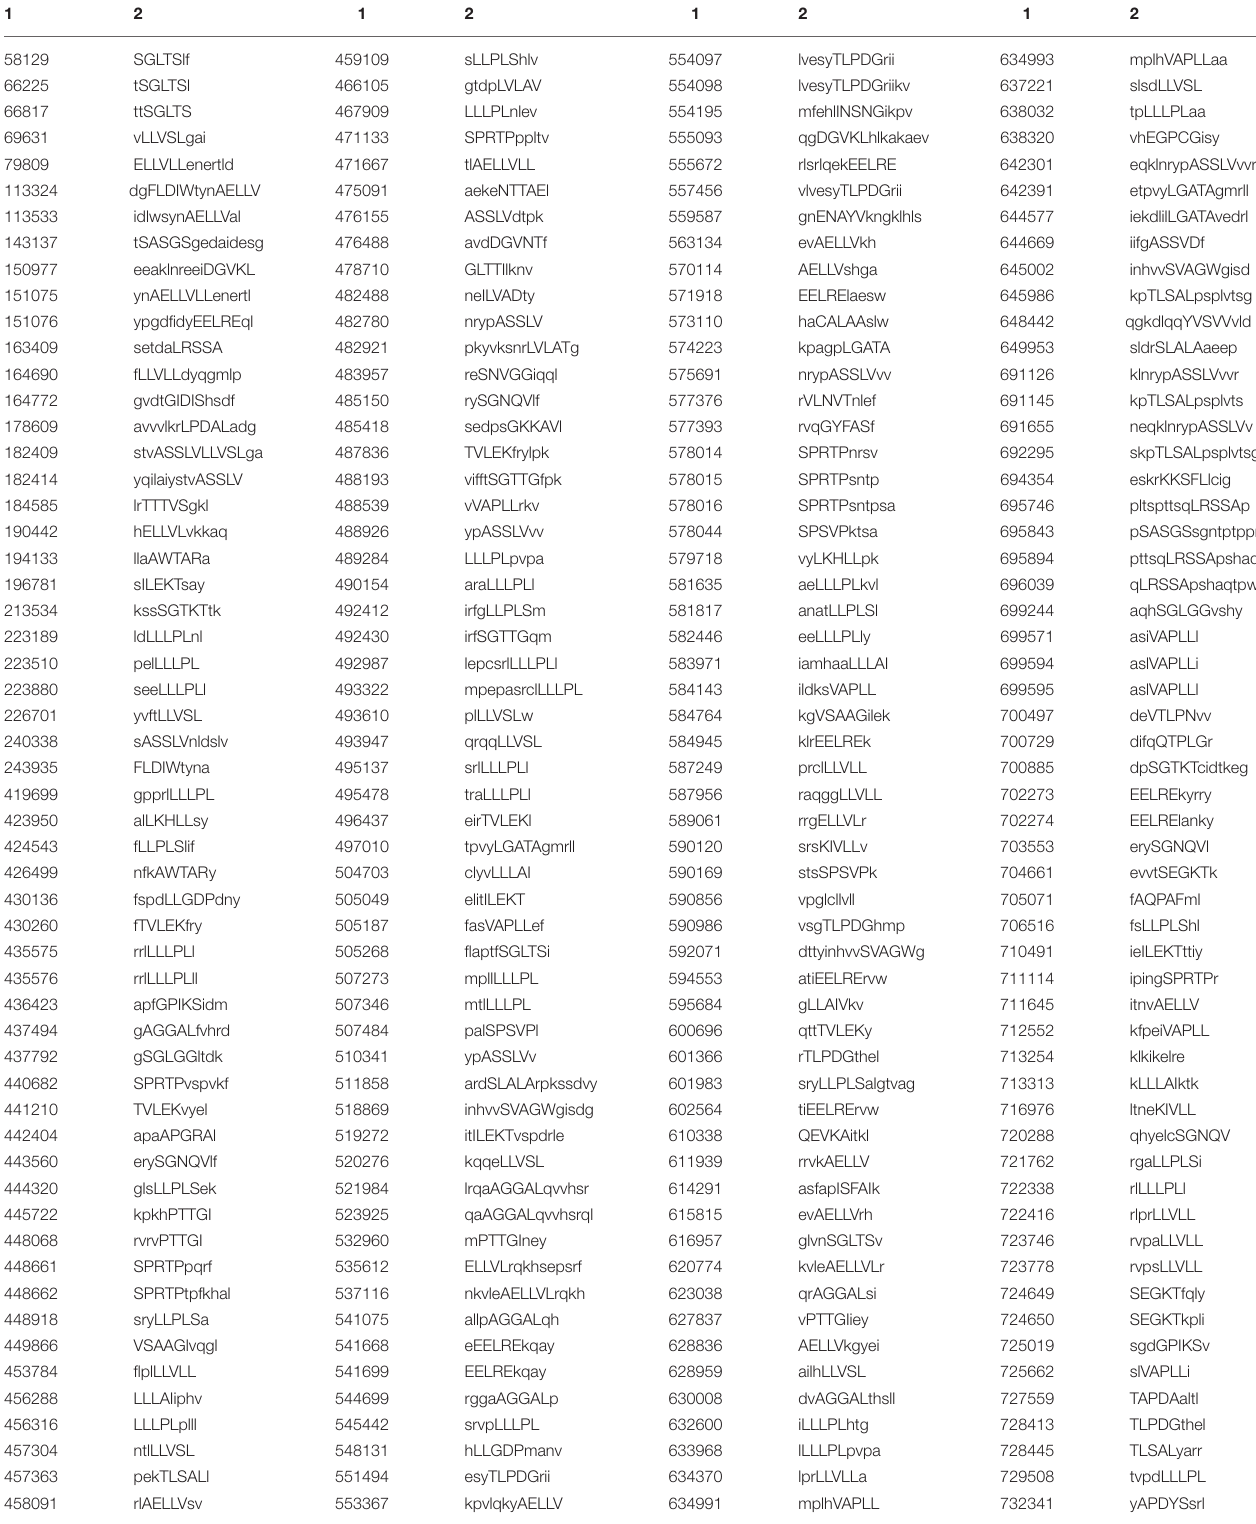
TABLE 2 | Epitopes immunopositive in the human host and containing peptide sequences common to antigens from stroke-related pathogens and human proteins associated with